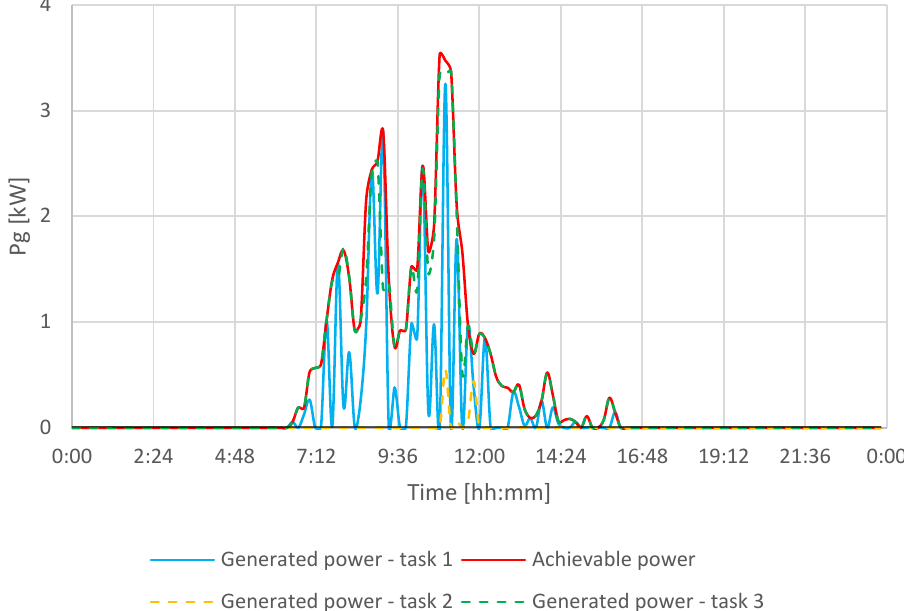
Figure 11. Daily changes of the operating states of the selected microsource (PV12).